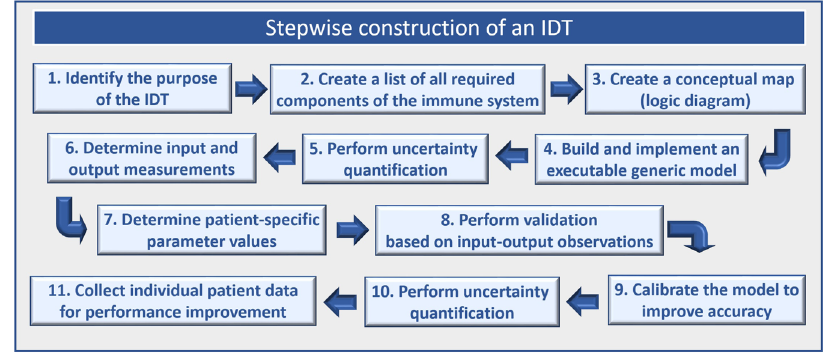
Fig. 2 Immune digital twin work fl ow. The 11 steps in the four-stage work fl ow to construct an immune digital